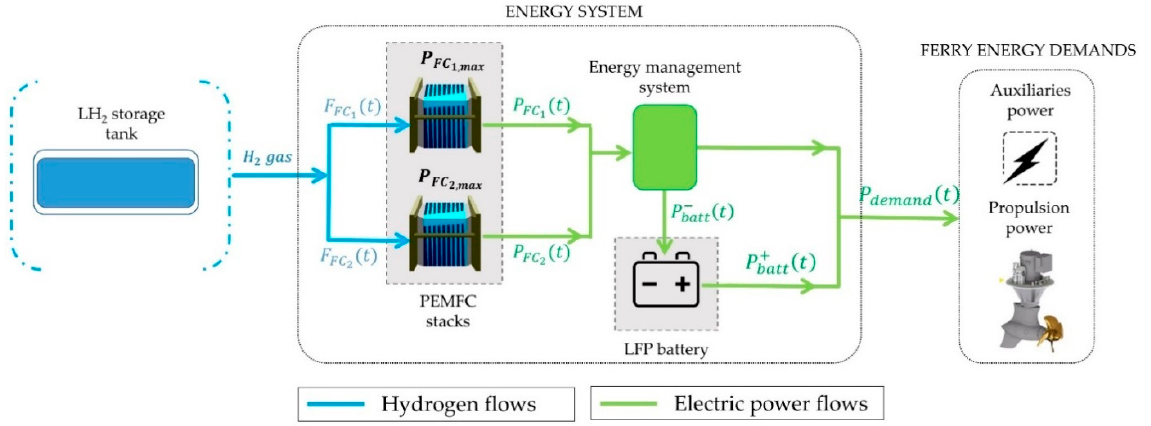
Figure 2. A simplified schematic of the proposed hybrid PEMFC/LFP battery propulsion system for the small-size ferry taken as a case study. Cryogenic tank provides hydrogen to two PEMFC stacks that convert chemical energy into electricity. The latter is sent to an energy management system that directs the power flows to fulfill the energy demand of the ferry (propulsion and auxiliaries demands) and/or to charge the battery. Table 3. Input parameters of the multi-objective optimization.